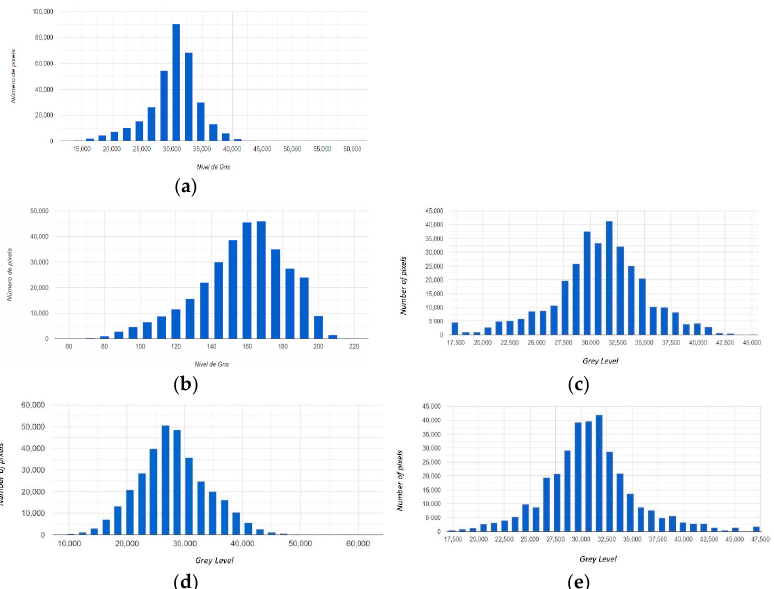
Figure 2. Histogram matching. ( a ) Histograms of band I (Infrared) of the original Image of July (reference). Following images represent histograms before (left) and after correction: ( b ) the original image of May, ( c ) the homogenized image of May, ( d ) the original image of September, ( e ) the homogenized image of September.